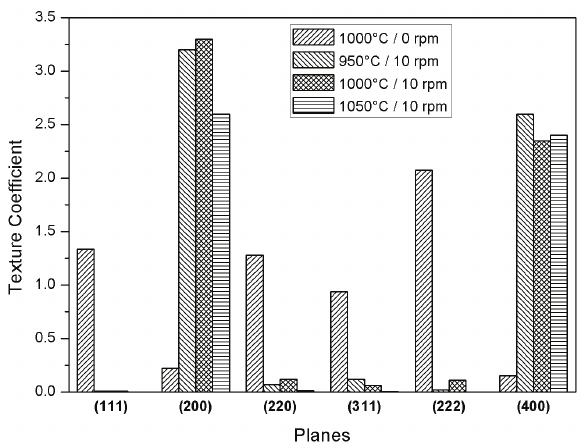
Figure 3. Texture coefficients of the various 7YSZ coatings deposited in this